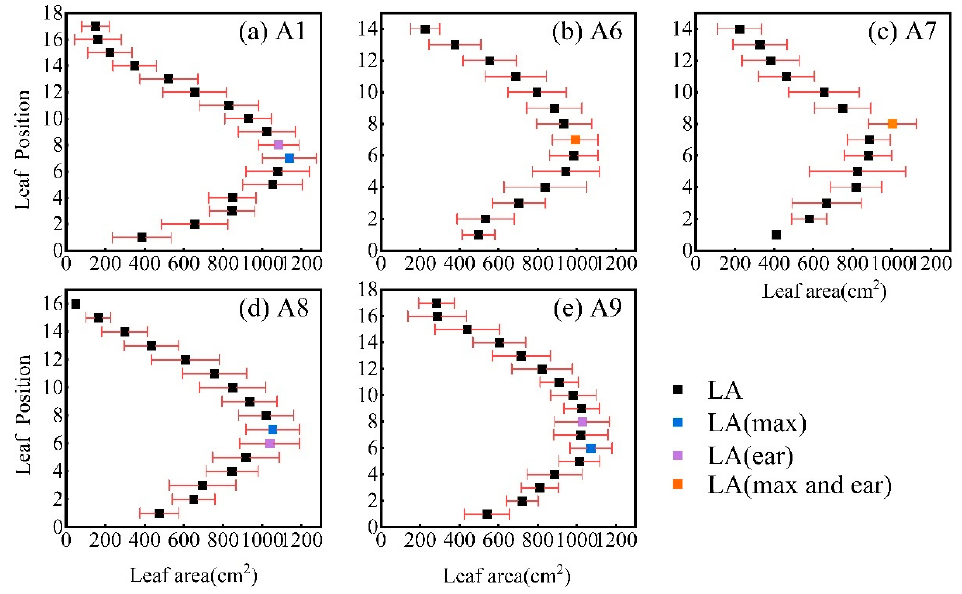
Figure 11. Relationship between EH and leaf area of di ff erent cultivars at fi lling period in 2021( a – e ) cultivars A1, A6–A9 in 2021.